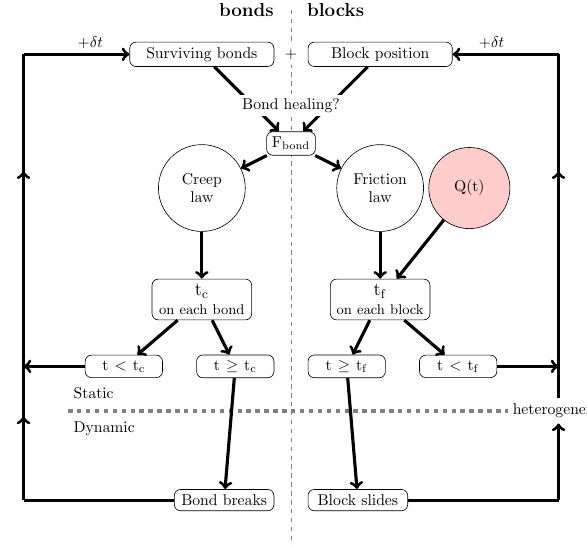
Fig. 9. Schematic flowchart of the spring-block model modified from Faillettaz et al. (2010) accounting for subglacial water